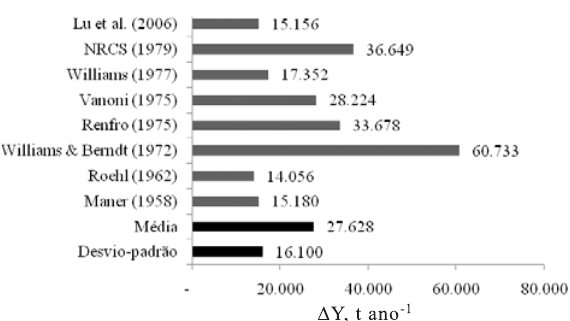
Figura 7. Reduções na produção de sedimento anual ( ΔΔΔΔΔ Y) em função de redução de 50 % na erosão total na bacia do ribeirão